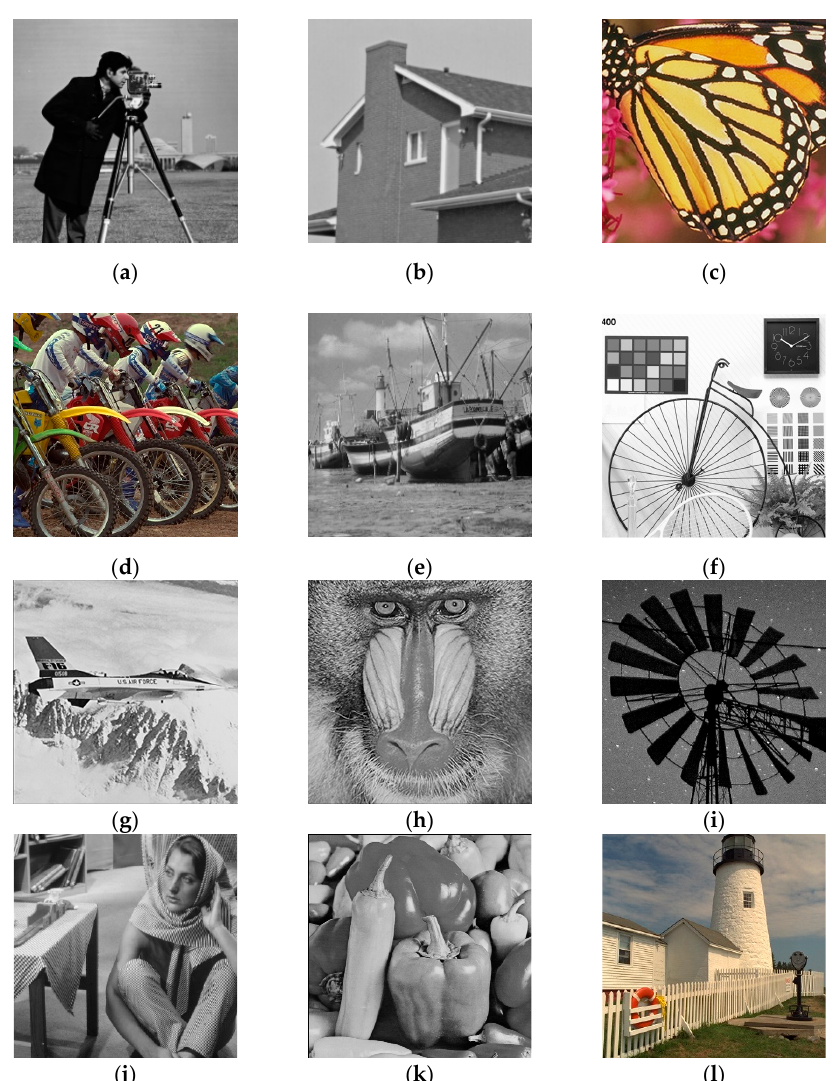
Figure 10. Test images. ( a ) cameraman; ( b ) house; ( c ) butterfly; ( d ) bike; ( e ) boats; ( f ) wheel; ( g ) airplane; ( h ) baboon; ( i ) stars; ( j ) barbara; ( k ) peppers; ( l ) fence.